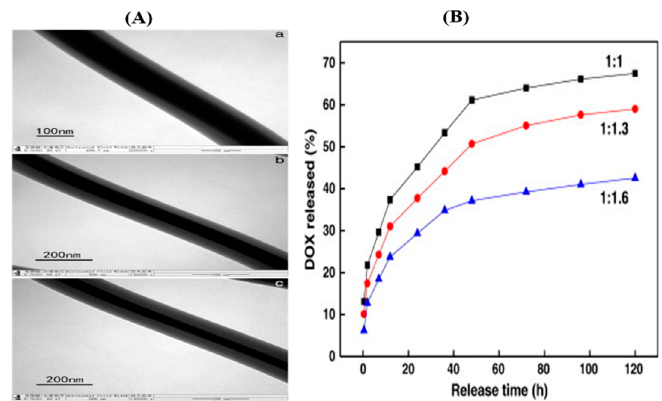
Figure 5. ( A ) TEM image of poly(vinyl alcohol) / chitosan (PVA / CS) core-sheath nanofibers with di ff erent feed ratios of ( a ) 1:1, ( b ) 1:1.3, and ( c ) 1:1.6 and ( B ) drug release profiles [68]. Reprinted with permission from Materials Science and Engineering: C. Copyright Elsevier, 2014.